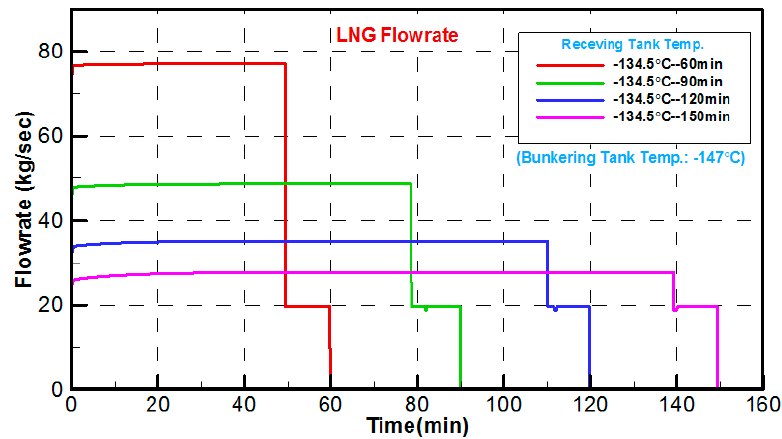
Figure 9. Relation between the LNG flow rate and the respective bunkering times.